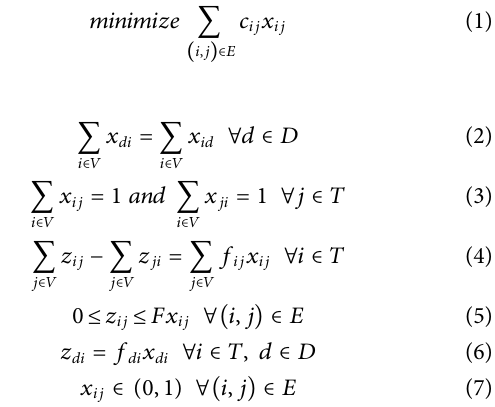
Frontiers in Robotics and AI |